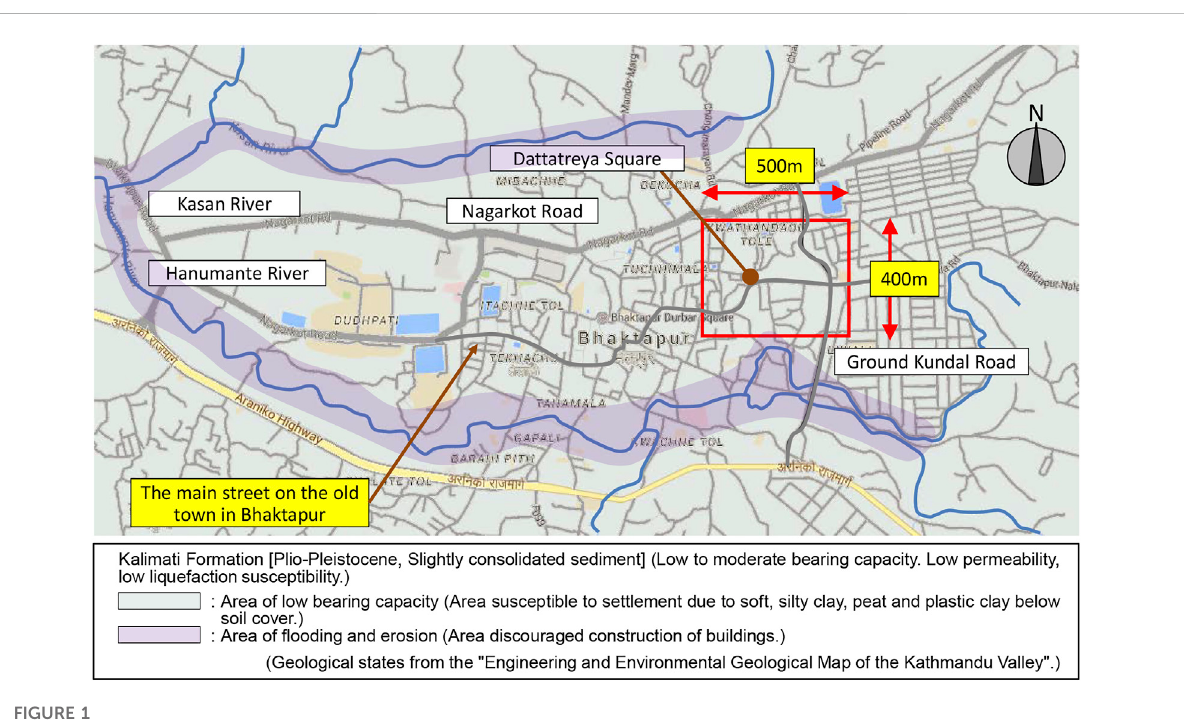
FIGURE 1 Location of the surveyed area and geological condition of the old town in Bhaktapur. (The background map was reprinted from the Google Maps